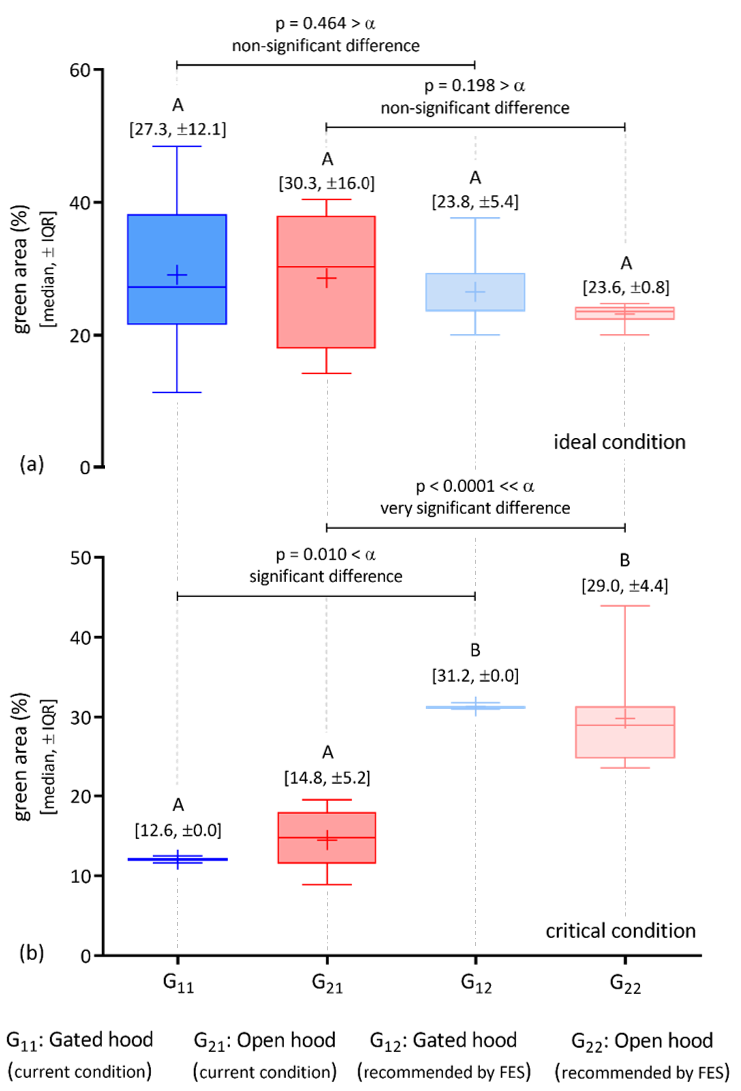
ANALYSING GREEN AREAS IN URBAN NEIGHBORHOODS